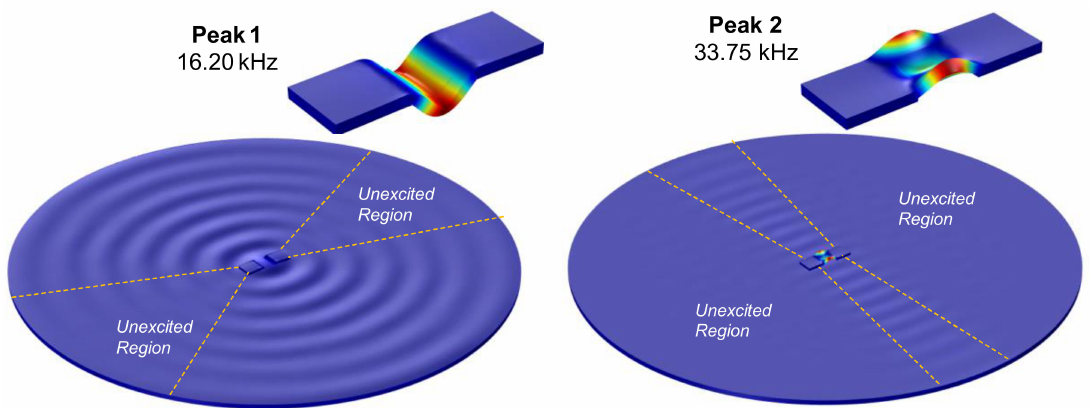
Figure 4. Coupled vibration modes of the PZT interface-plate domain system.